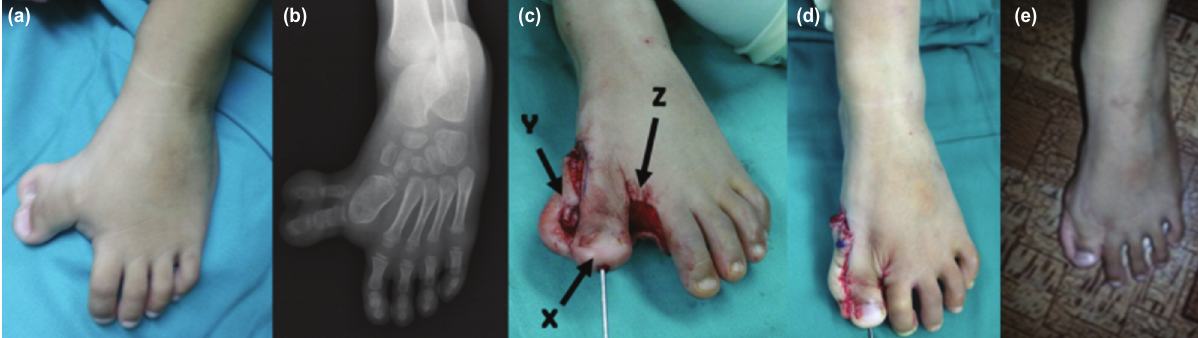
(a,b) Pre-operative photograph and radiograph of case No. 2 show polysyndactyly and congenital hallux varus of the left big (d)Fig. 2: toe. (c) The realigned big toe ‘x’ held with K-wire after medial soft tissue release with plantar based skin flap ‘y’ after filleting of bone in the extra digit and resection of the skin in the first web space ’z’. (d) The extra skin sutured to cover the medial skin defect and the first web space closure. (e) Post-operative photograph after 3 years.